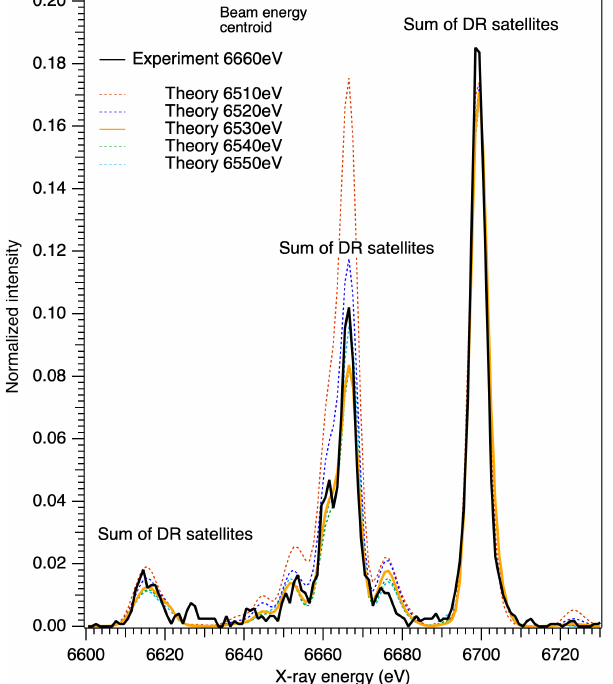
Figure 2. Comparison of normalized measured and theoretical spectra of Fe ions at the nominal experimental beam energy of 6660 eV. The observed spectrum is shown by a solid black line and the best theoretical match is shown by a solid orange line.